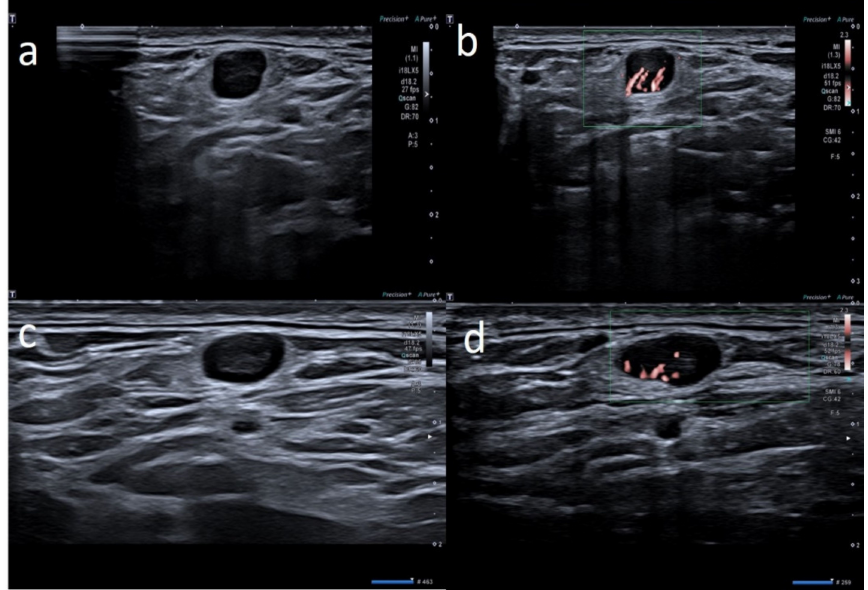
Figure 5. 35-year-old male with palpable unilateral sopraclavicolar adenopathy noted 3 days after receiving the first dose of the Pfizer-BioNTech COVID-19 vaccine in his left deltoid muscle. ( a ) B- mode sonogram image shows a round, hypoechoic lymph node with hilum absence. ( b ) SMI images show central and peripheral vascularization. ( c ) After 2 weeks, sonogram image shows ovular morphology, asymmetric cortical thickening but with faint hilum reappearance. ( d ) After 1 month, the cortical thickening appears uniform, with hilum evidence and normal vascularization.